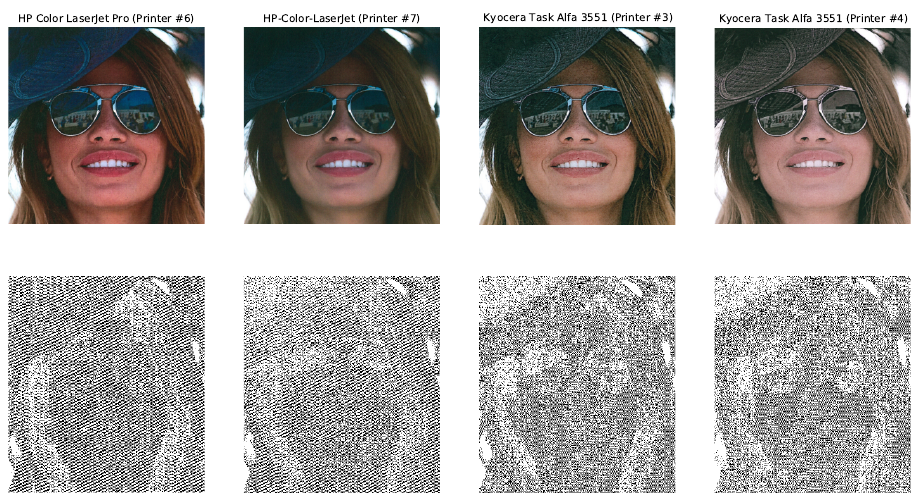
Figure 2. The same image (193.jpg) printed by four different printers and their corresponding HH discrete wavelet transform subbands (luminance